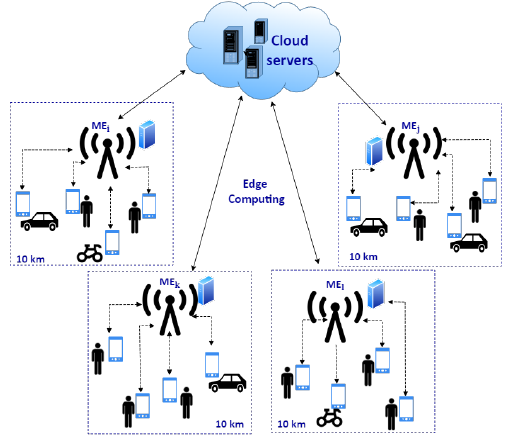
Figure 1. Decentralized edge-enabled MCS